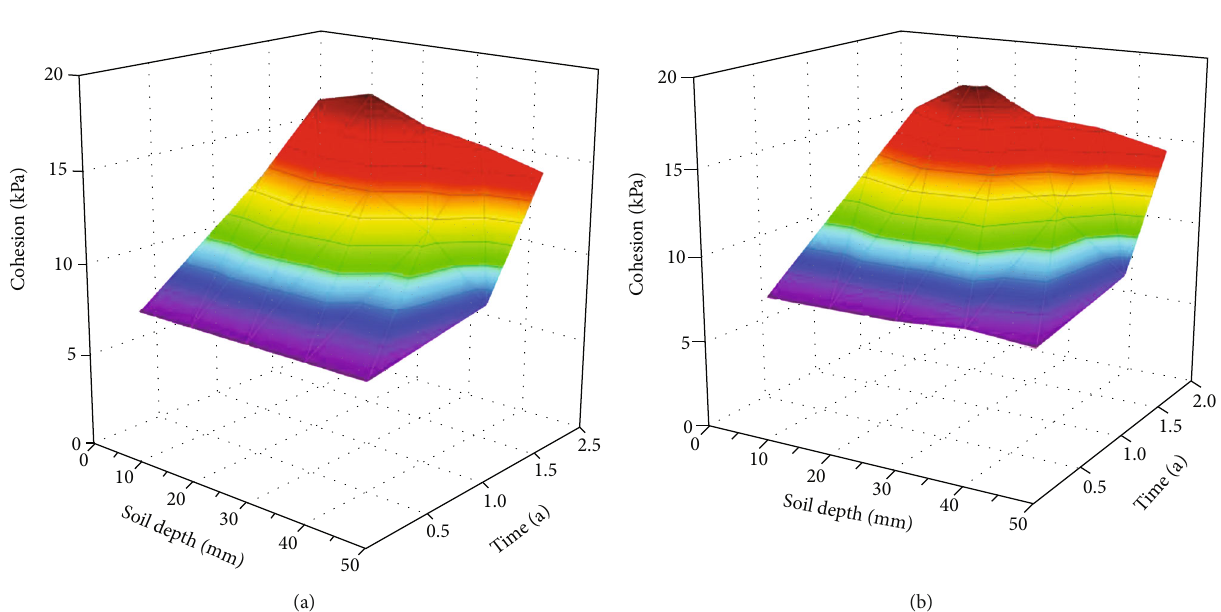
Figure 11: Cohesion of root-bearing soil at di ff erent growth periods and di ff erent depths: (a) test value; (b) predicted value.